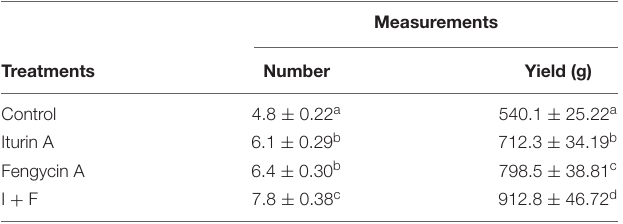
TABLE 7 | Promotional effect of Iturin A and Fengycin A on potato number and yield in field trials.